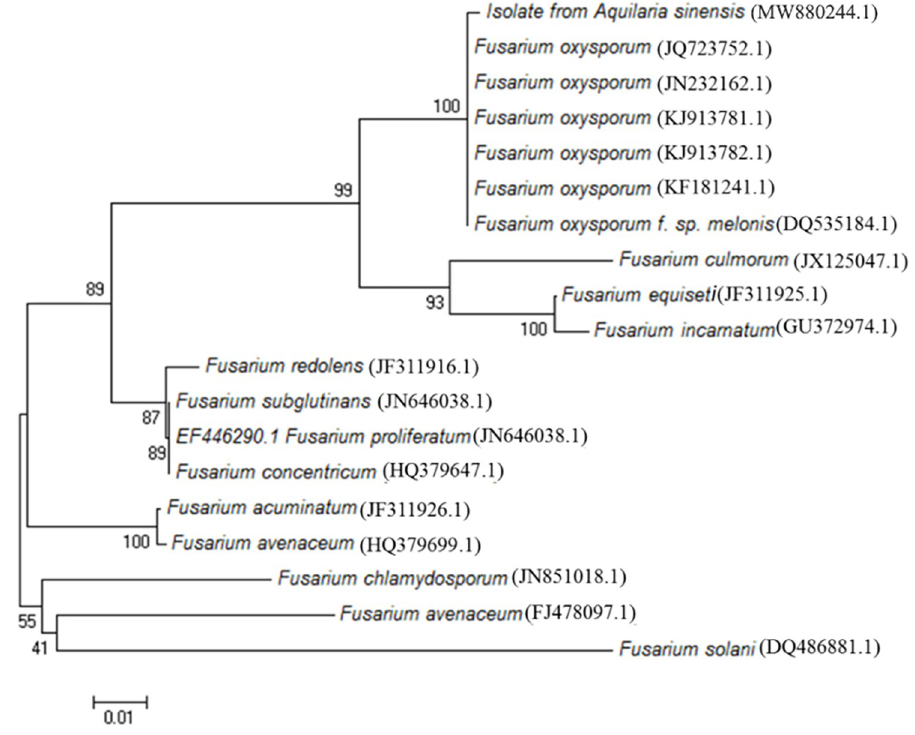
Fig 2. Phylogenetic analysis of the isolated F . oxysporum with a selection of Fusarium species.